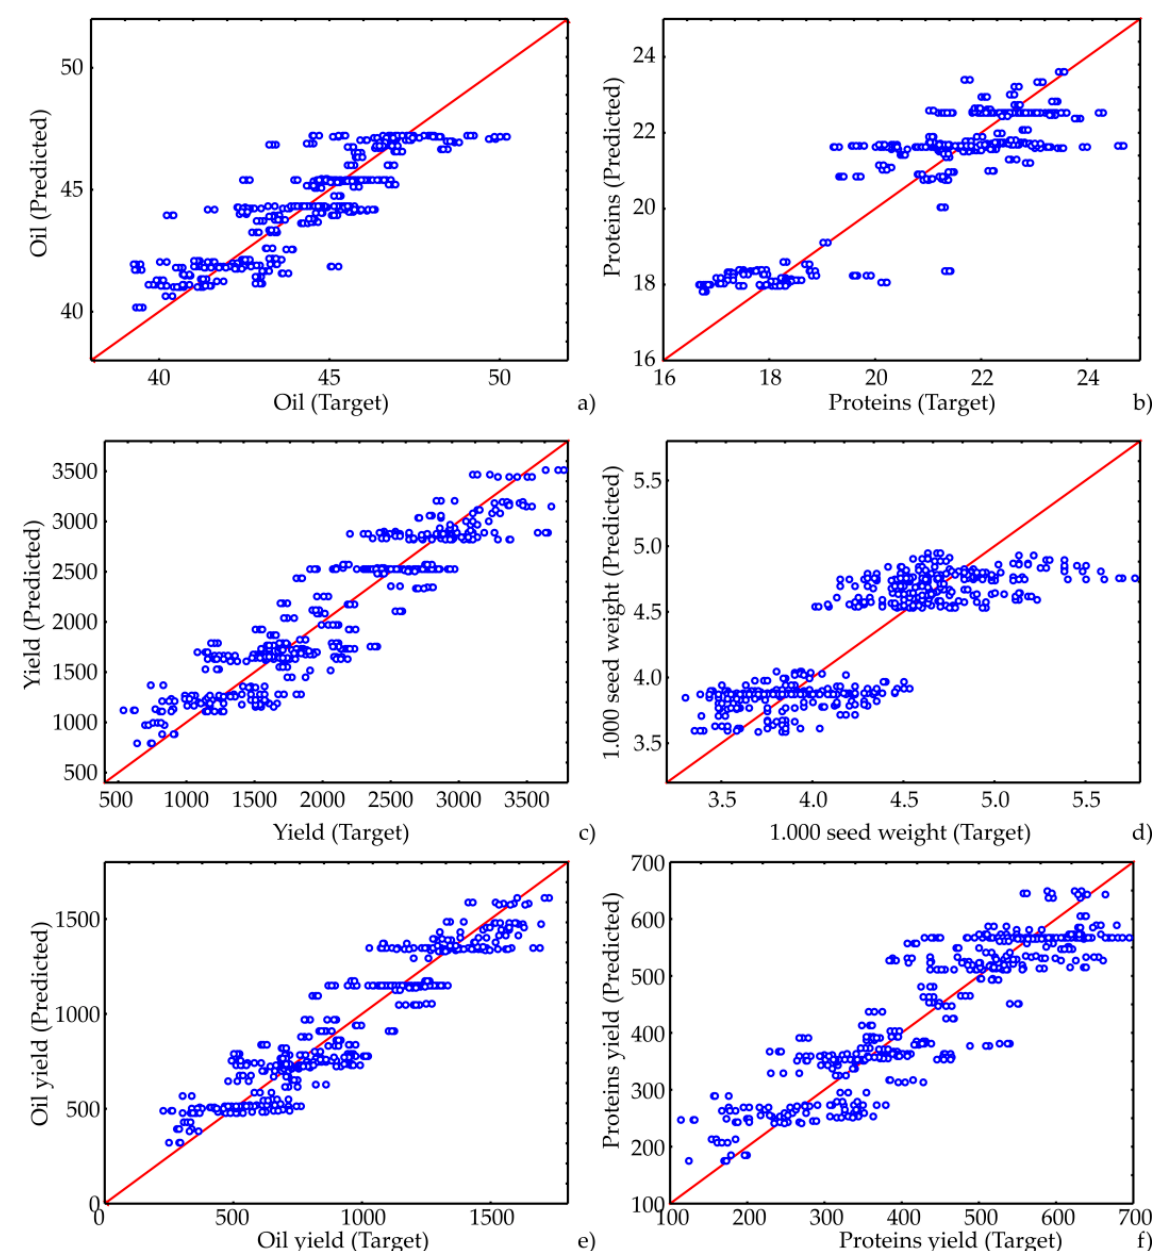
Figure 2. Comparison between experimentally obtained and ANN model predicted values of ( a ) oil and ( b ) protein content, ( c ) yield, ( d ) 1000 seed weight, ( e ) oil yield, and ( f ) protein yield.